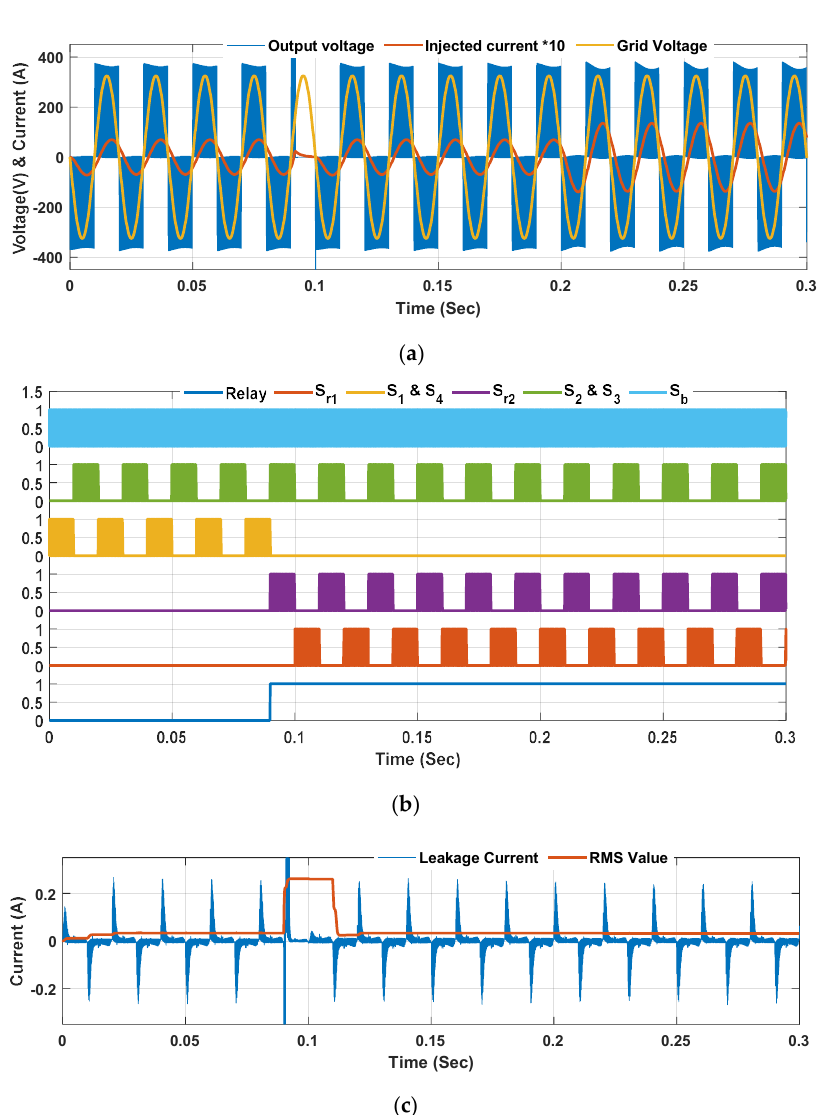
Figure 16. Performance when a fault occurs in one of the legs with the load change, ( a ) output voltage, injected current and grid voltage, ( b ) switching and relay signals; and ( c ) leakage current.